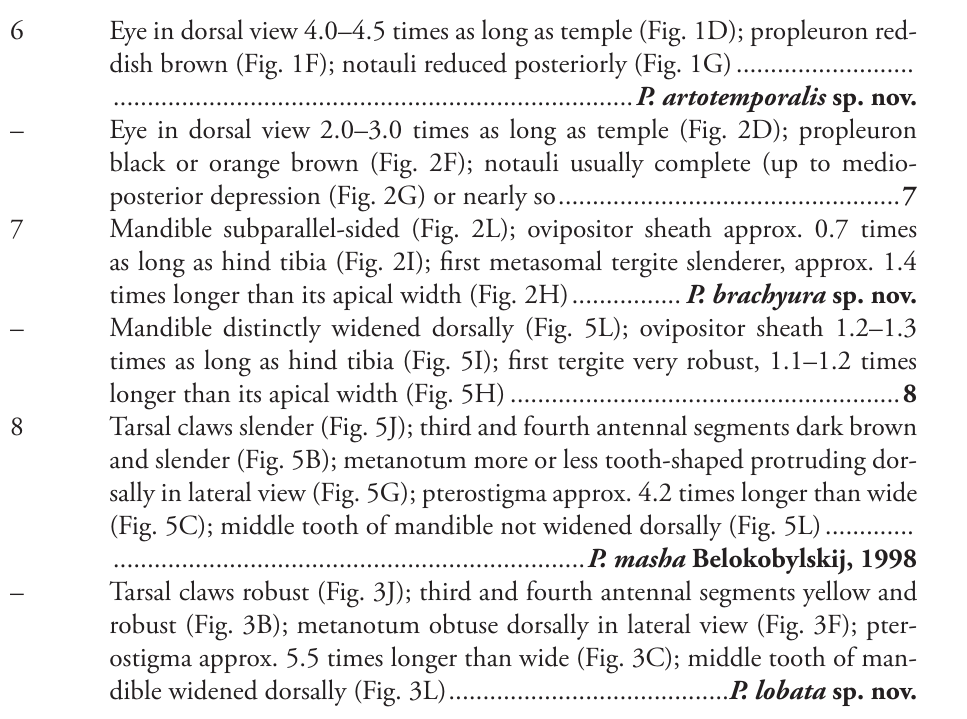
Type material. Holotype , ♀ (KNA), South Korea , DMZ Botanical Garden, Mandae- ri, Haean-myeon, Yanggu-gun, Gangwon-do, 38°15'09.3"N, 128°06'40.6"E, 08–21. VIII.2017, Shin, Kim. GenBank accession no. MZ318086 for the barcoding sequence of the COI region Comparative diagnosis. Differs from other species in the group of Phaenocarpa species by notauli reduced posteriorly by having the eye in dorsal view 4.0–4.5 times as long as temple (2.0–3.0 times in other species). Closely related to P. brachyura sp. nov., for differences see key above. Description. Holotype , ♀ : length of body in lateral view 2.0 mm, length of an- tenna 3.2 mm, and length of fore wing 2.6